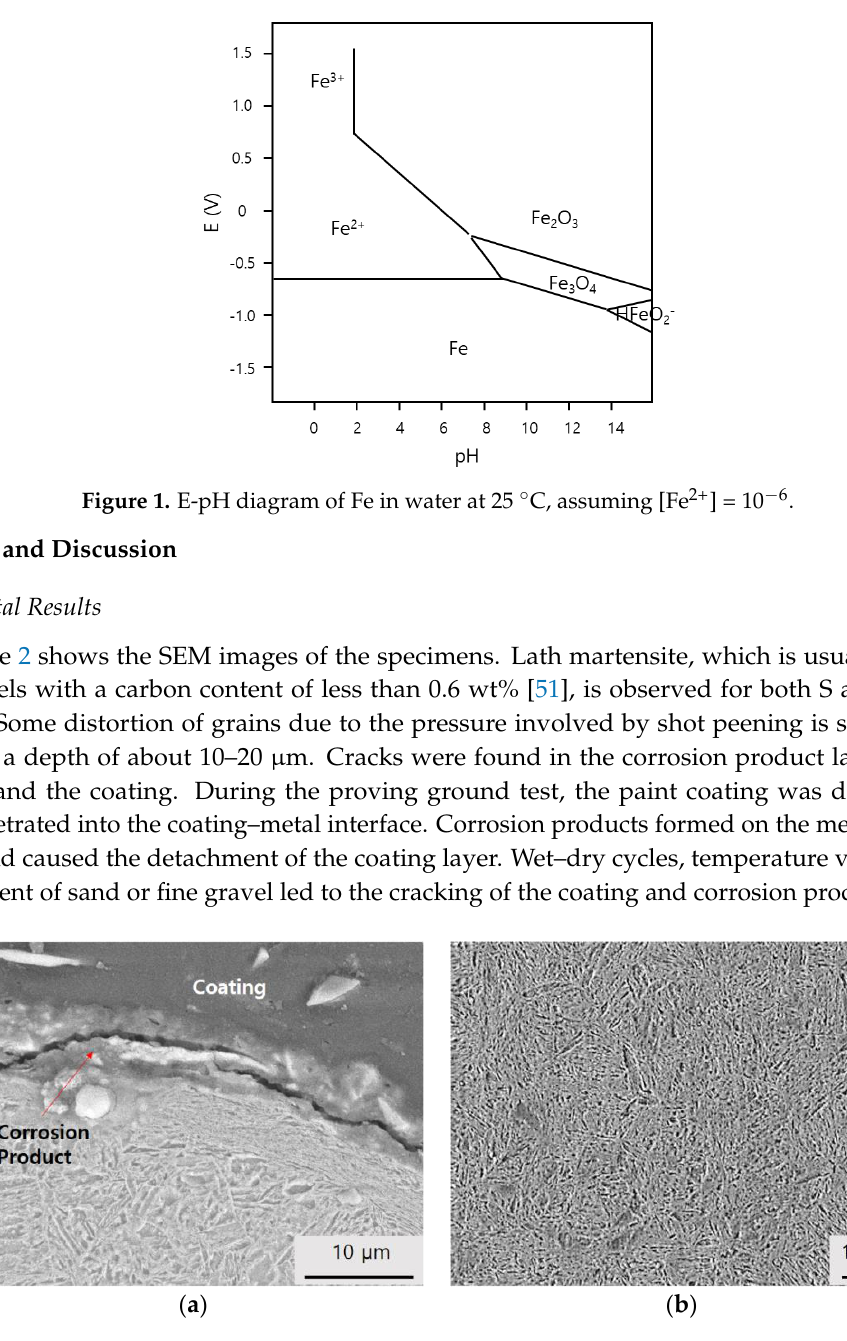
Figure 2. Microstructure of cross sections ( a ) near the surface and ( b ) at the middle of the spring.